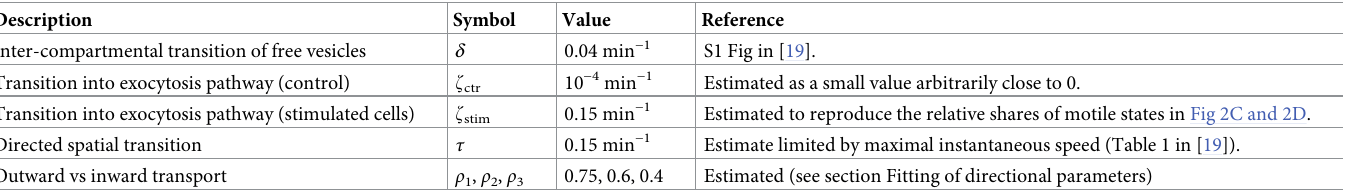
Table 1. Parameter